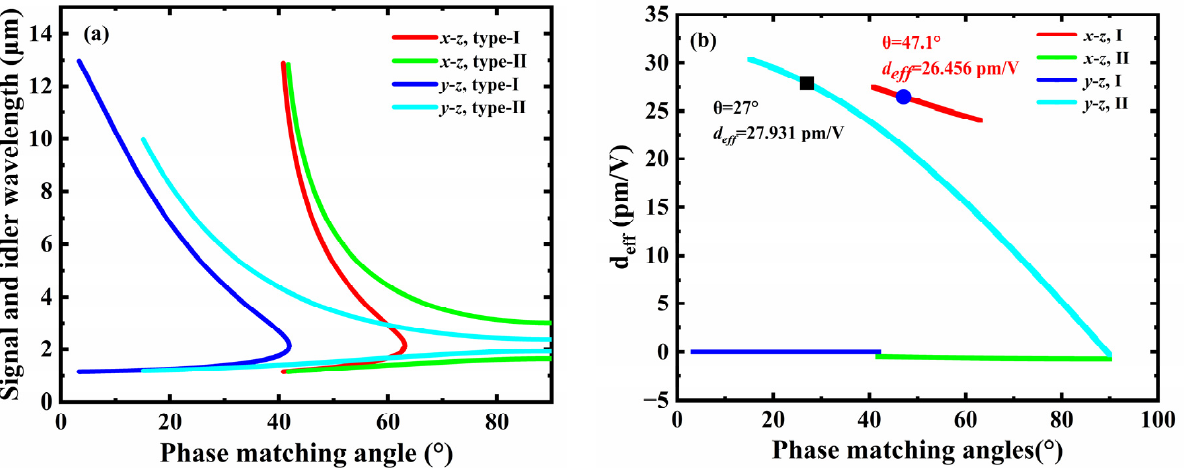
Figure 1. Calculated phase-matching characteristics of BGSe-OPO pumped by 1.064 µ m laser. ( a ) Phase-matching angles versus OPO signal and idler wavelength at the x - z principal plane and y - z principal plane of BGSe crystal. ( b ) The OPO effective nonlinear optical coefficients d eff versus phase-matching angles at the x - z and y - z principal planes.